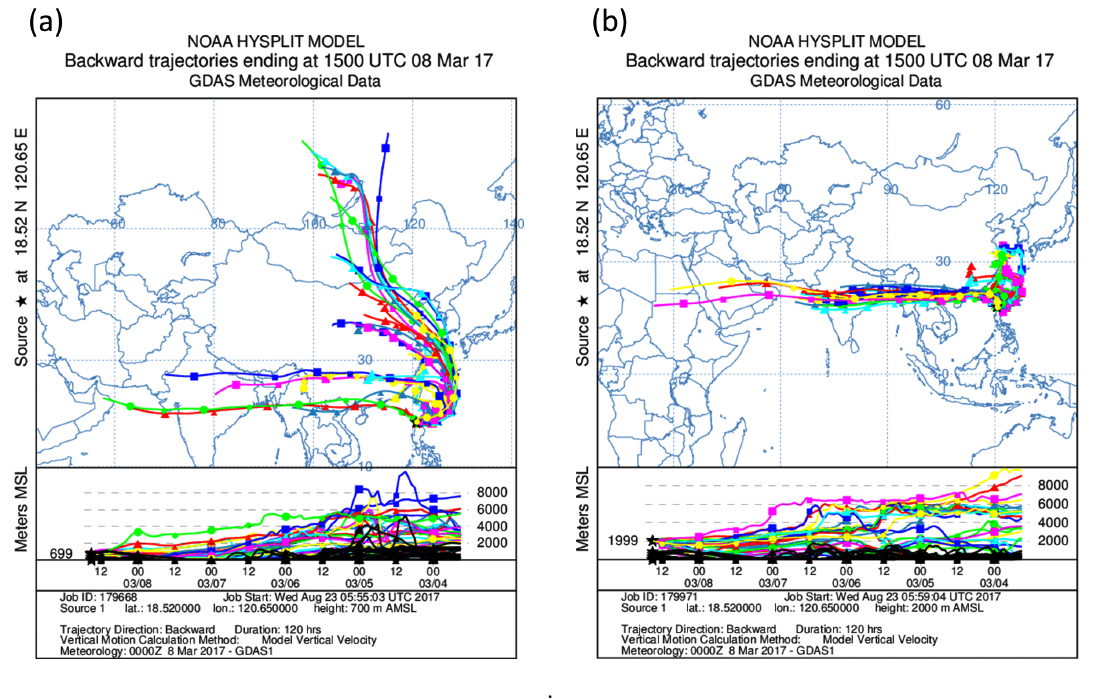
Figure 6. The 120-h HYSPLIT model backward trajectory of 27 air parcels (colors) and terrain height (black line) from Burgos at ( a ) 700 m and ( b ) 2000 m above sea level (a.s.l) ending at 15:00 UTC on 8 March